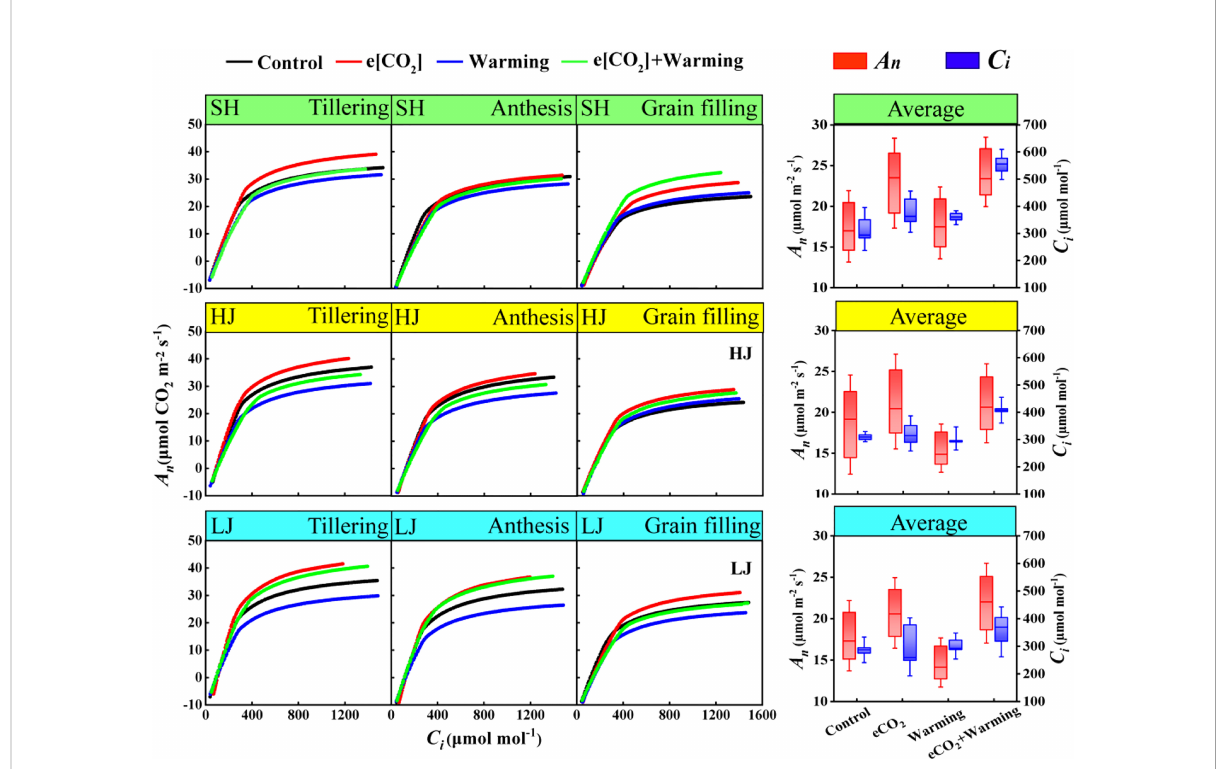
FIGURE 4 The line graph represents the net photosynthetic rate ( A n )- intercellular carbon dioxide concentration ( C i ) curves under ambient [CO 2 ] and temperature (black dots, Control), e[CO 2 ] (red dots, e[CO 2 ]), warming (blue dots, warming), and e[CO 2 ] plus warming (green dot, e[CO 2 ] +warming) at the tillering, anthesis, and grain- fi lling stages (from left to right) in SH (Shishoubaimao), HJ (Hejiang 19), and LJ (Longjing 31) (from top to bottom). The box graph represents the average net photosynthetic rate ( A n , red boxes) and intercellular carbon dioxide concentration ( C i , blue boxes) when the carboxylation rate is